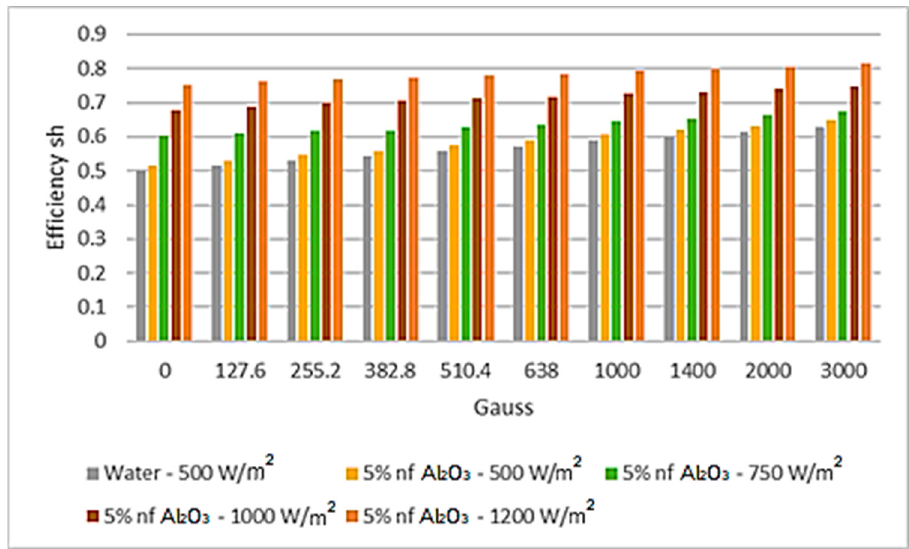
Figure 17. Hybrid thermal energy efficiency generated by PV-Th solar panels with different solar radiations.